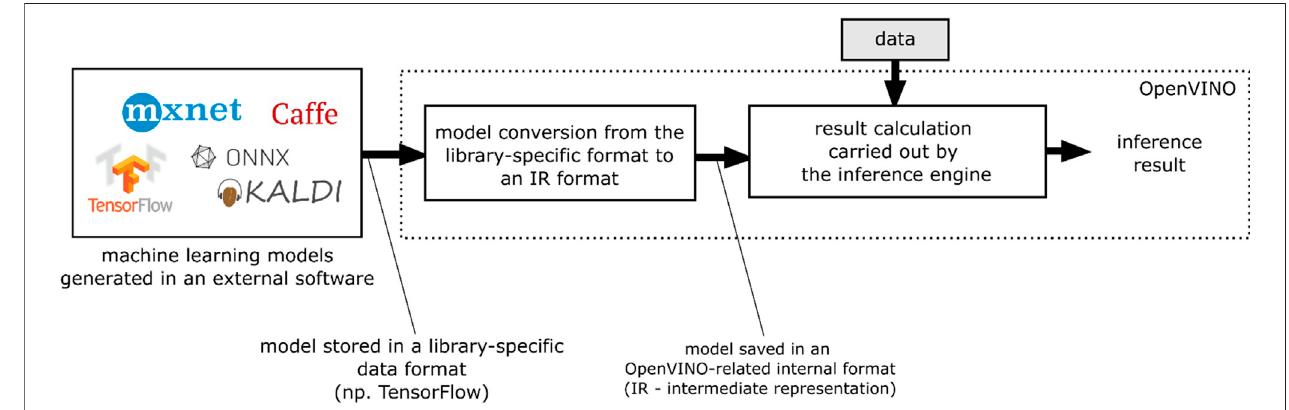
FIGURE 8 | Schematic representation of successive model conversion steps from formats used by popular libraries for implementing machine learning algorithms to the internal format of the OpenVINO tool.